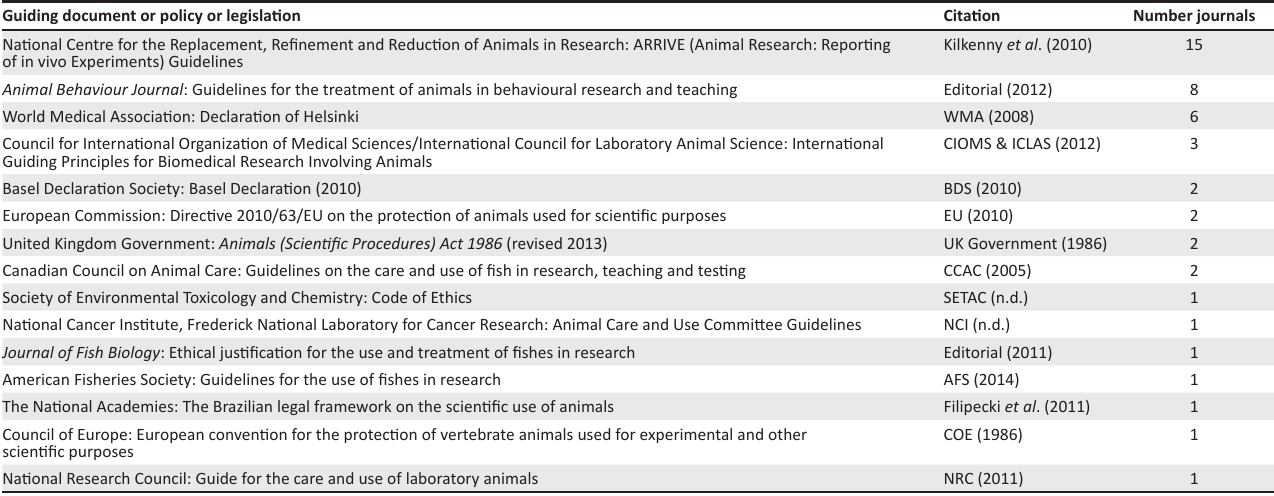
TABLE 1: Guiding documents for the ethical treatment of animals in research, stipulated by 45 ISI-rated, peer-reviewed journals that publish primary research on fishes, which must be followed by authors submitting research for publication in these journals. Guiding document or policy or legislation